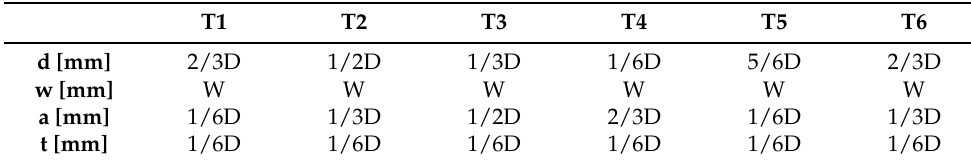
Table 2. Geometric specifications.